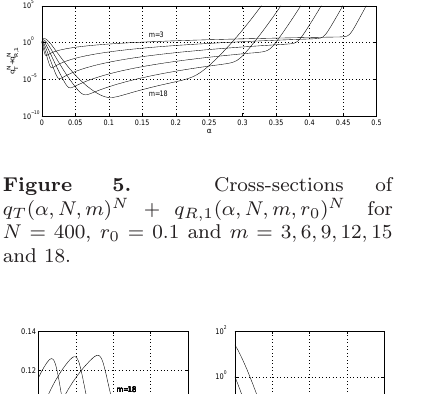
m=18m=3 m=18m=3 m=18m=3